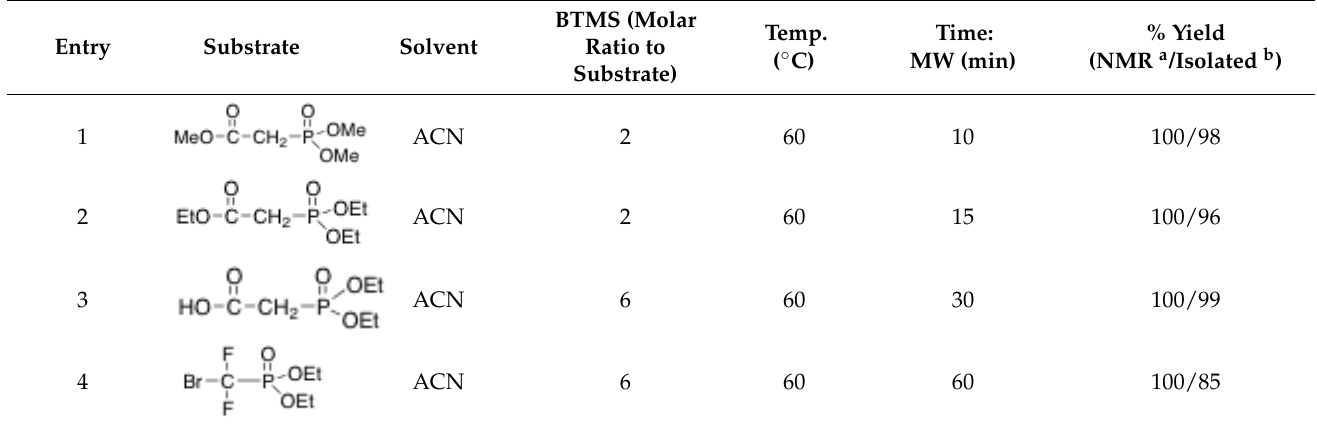
Table 2. Results for microwave BTMS dealkylation reactions on mixed carboxylate–phosphonate esters, as well as on 2-(diethoxyphosphoryl)acetic acid and diethyl(bromodifluoro)phosphonate.